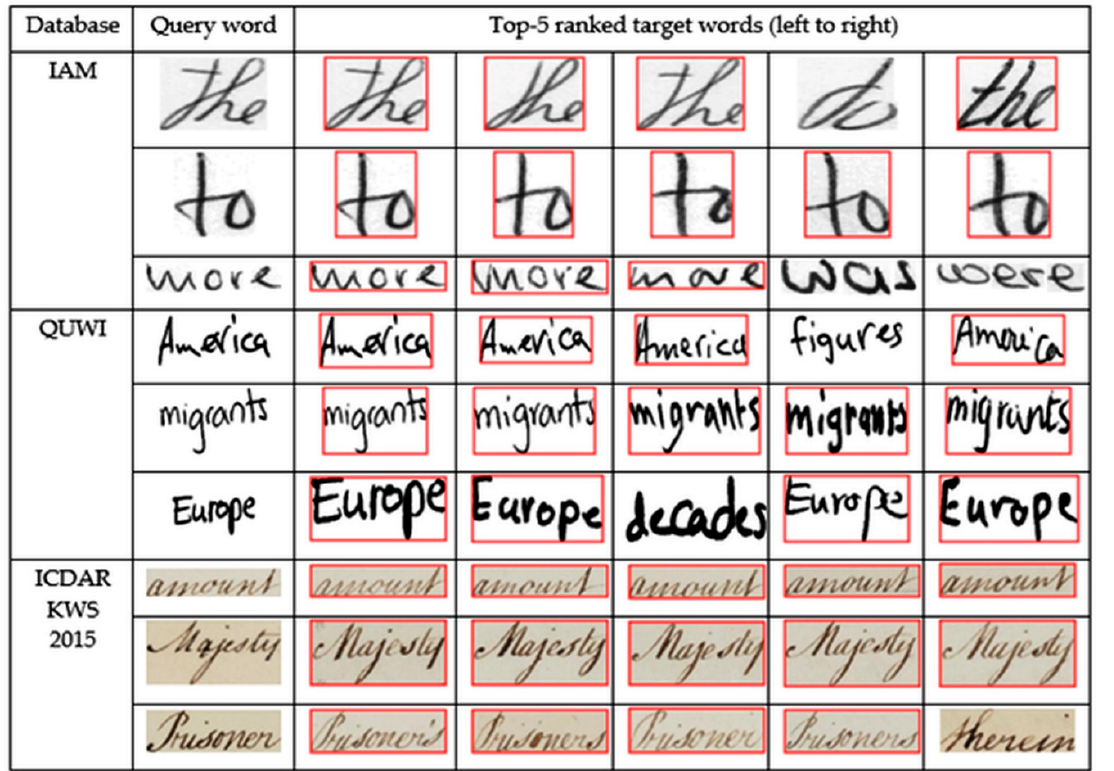
Figure 11. Top 5 ranked retrieved target words for the given query word taken from IAM, QUWI, and ICDAR KWS 2015 database. Words with red-colored bounding represent correctly retrieved word images while the rest represent wrongly retrieved word images.